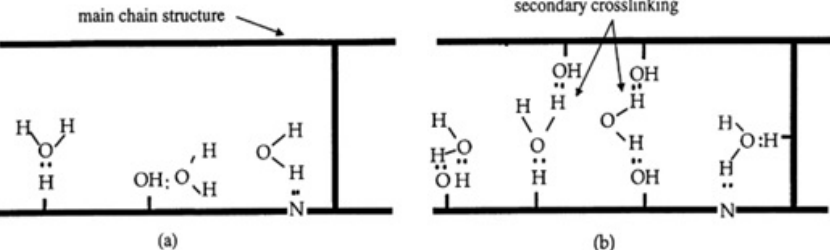
Figure 9. Illustrative scheme of possible water bonds with the epoxy resin polymer chains as proposed by Zhou and Lucas 37